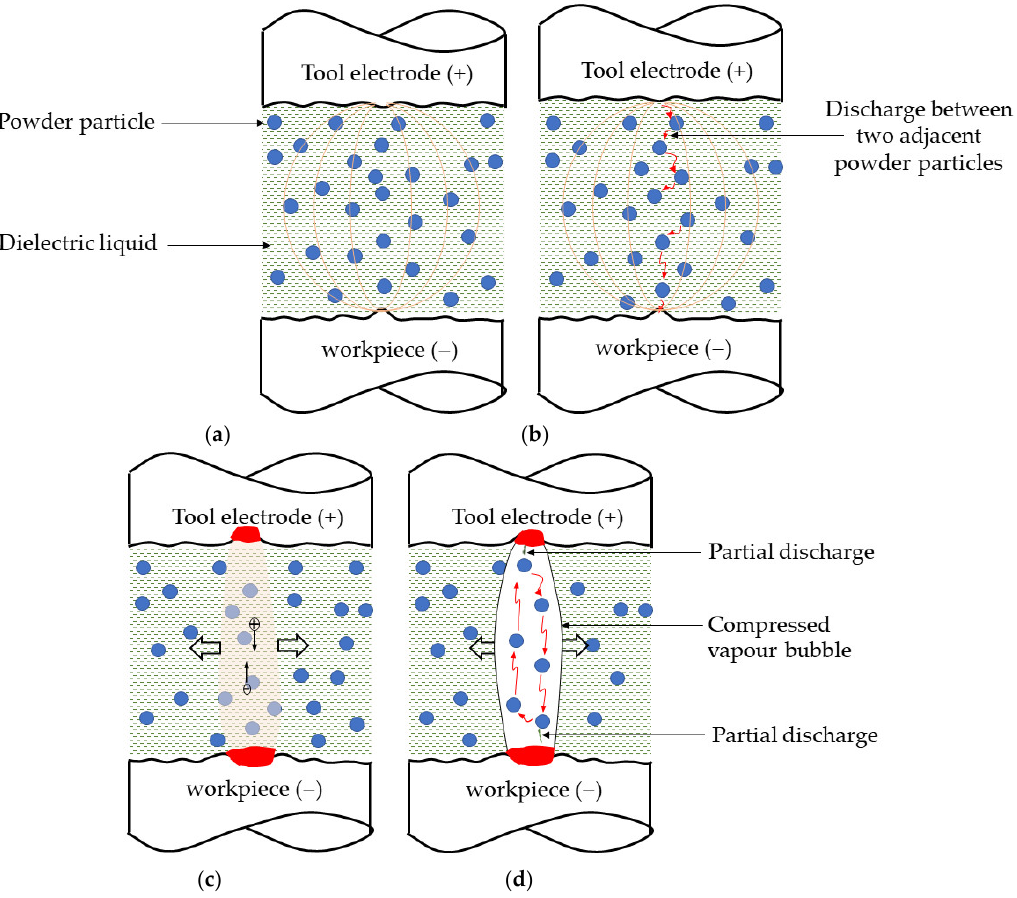
Figure 8. Schematic representations for partial discharge phenomena in PMEDM process. ( a ) Electric field aberration ( b ) Series discharge occur in-between the powder particles ( c ) Dis-charge channel formation ( d ) Occurrence of partial discharges.